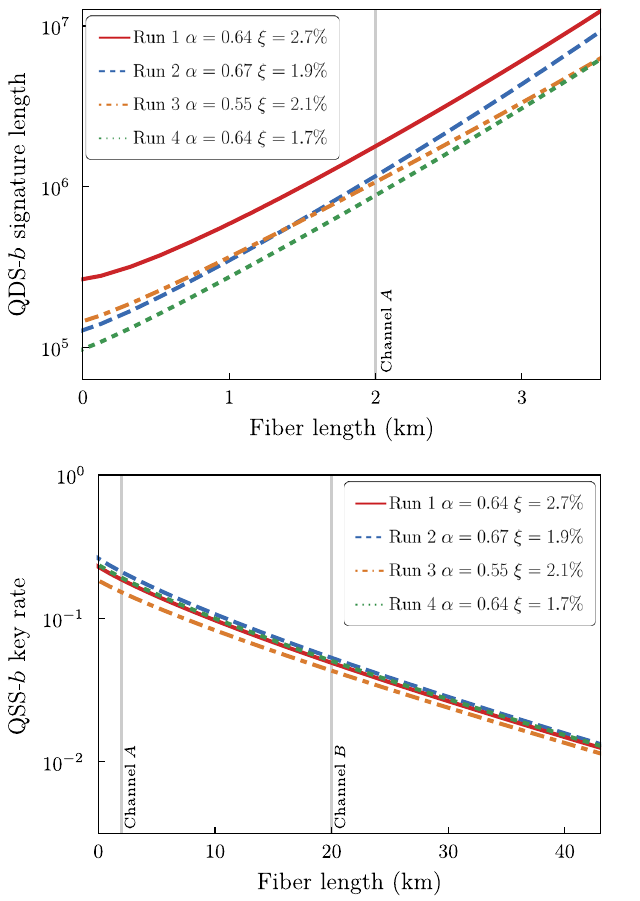
FIG. 6. Performance of agile and versatile system QDS- b -QSS- b -CV-QPSK. Top: QDS signature lengths under protocol QDS- b with an entangling-cloner attack. The signature lengths at a distance of 2 km remain modest both in the ideal (above) and experimental realizations (Table I), and the system is robust to choice of α . Bottom: maximum calculated QSS key rates under protocol QSS- b with a dishonest Eve performing a beam-splitter attack, and either Bob or Charlie dishonest. The key rate is robust to variations in α and remains large even for our 20-km channel. Solid (red), dashed (blue), dot-dashed (orange), and dotted (green) lines correspond to the performance deduced by param- eters from experimental runs 1, 2, 3, and 4, respectively. Vertical grid lines depict loss levels over experimental channels A and B corresponding to fiber lengths 2 km (0.65-dB loss) and 20 km (4.75-dB loss).